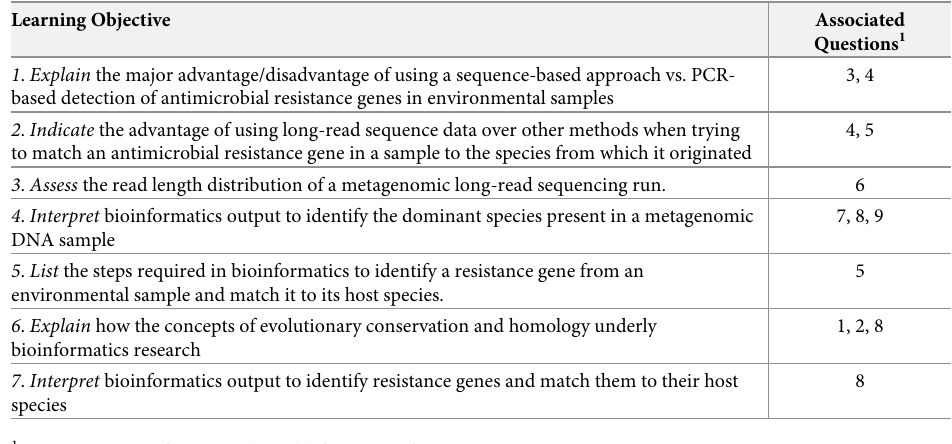
Table 2. PARE-Seq learning objectives and associated pre- and post- assessment